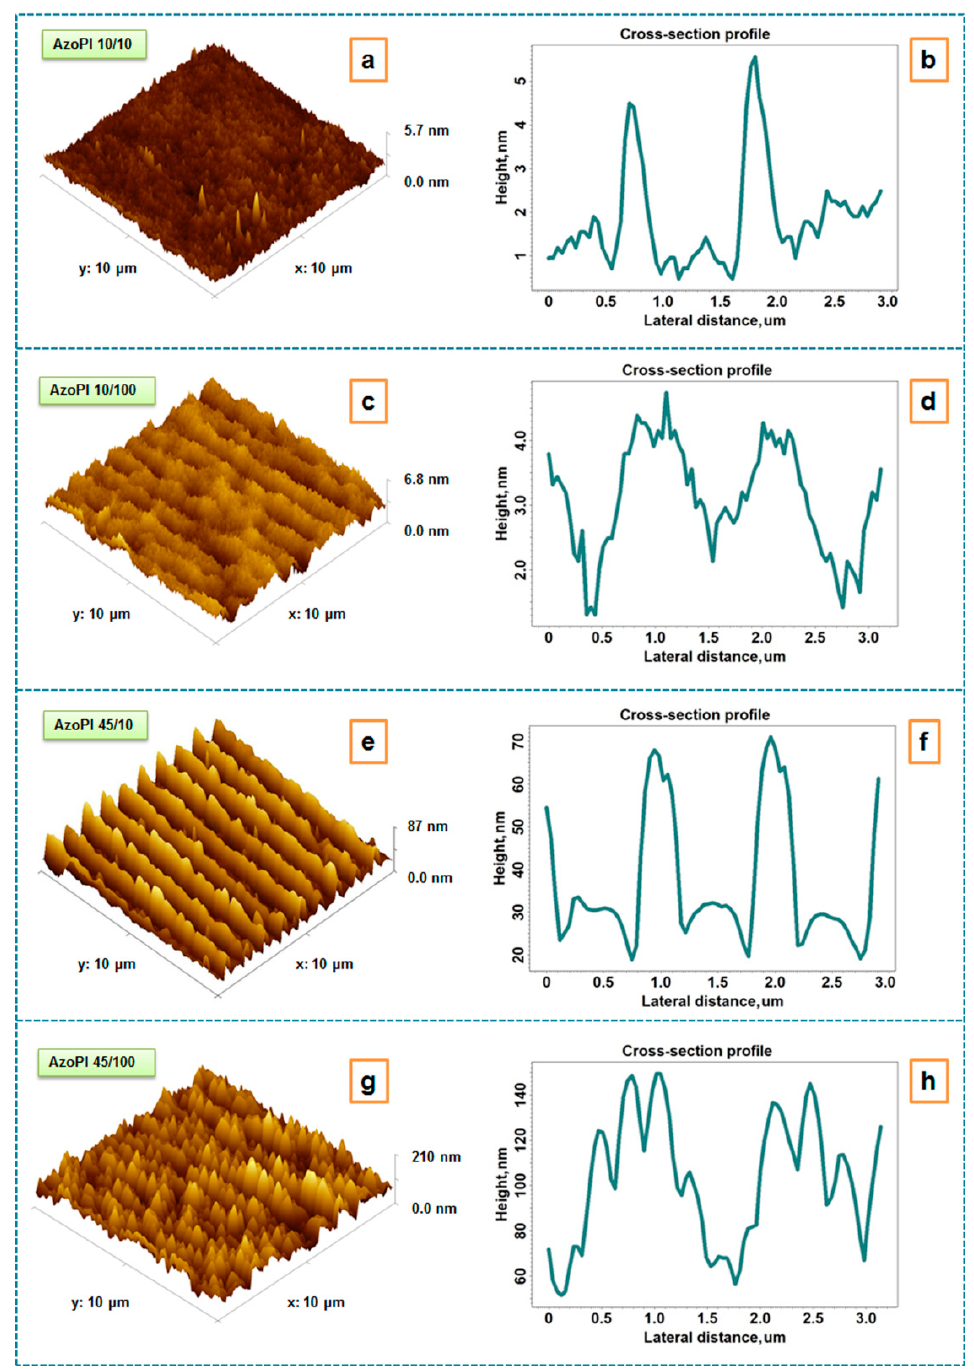
Figure 3. Height 3D atomic force microscopy (AFM) images and corresponding cross-section profiles for azo-polyimide irradiated using different laser energy density/number of pulses of irradiation: 10 mJ/cm 2 /10 pulses ( a , b ), 10 mJ/cm 2 /100 pulses ( c , d ), 45 mJ/cm 2 /10 pulses ( e , f ), 45 mJ/cm 2 /100 pulses ( g , h ).